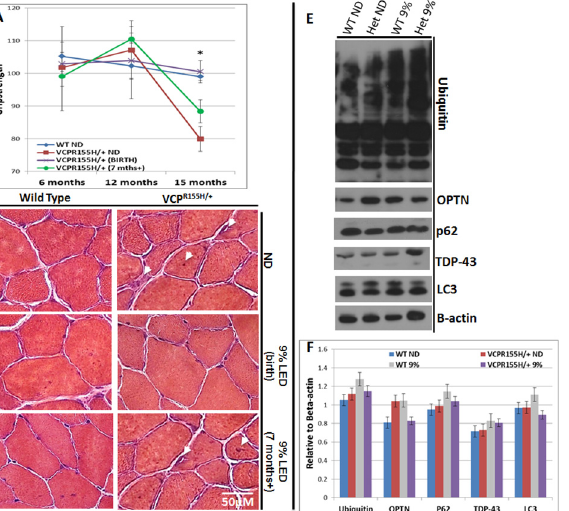
Fig 1. Grip strength measurements and histological analyses of WT and VCP R155H/+ mice on normal and 9% LED. (A) Grip strength measurements for the WT (blue) and VCP R155H/+ (red) mice placed on the 6% ND from birth and VCP R155H/+ mice placed on the 9% LED from birth (purple) and at 7 months of age onwards (green). H&E staining on WT and VCP R155H/+ on (B) ND (pathology shown by white arrows, right panel), (C) 9% LED from birth, and (D) 9% LED beginning at 7 months of age onwards (pathology shown by white arrows, right panel). (E) Western blot analyses of WT and VCP R155H/+ animals fed either ND or 9% LED. (F) Densitometry analyses relative to loading control (Beta-actin). Statistical significance is denoted by * P (cid:1)